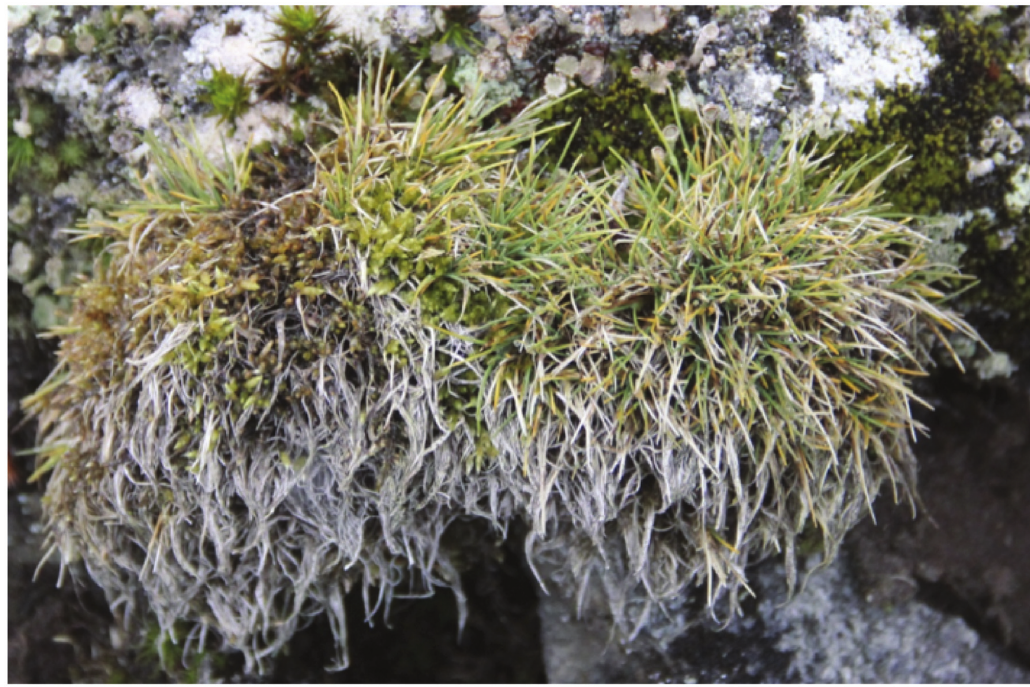
Figure 2 - Symptoms of P. deschampsii on D. antarctica